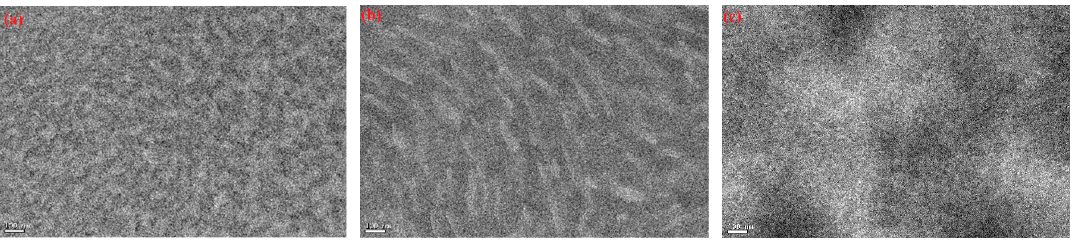
Figure 10. Transmission electron microscopy (TEM) bright field images of active layers for PDTBDT-TIPS-DTBT-OD/PC 71 BM (1:1.5, 0%DIO, a ), PDTBDT-TIPS-DTFBT-OD/PC 61 BM (1:1.5, 0%DIO, b ) and PDTBDT-TIPS-DTNT-OD/PC 71 BM (1:1.5, 3%DIO, c ).